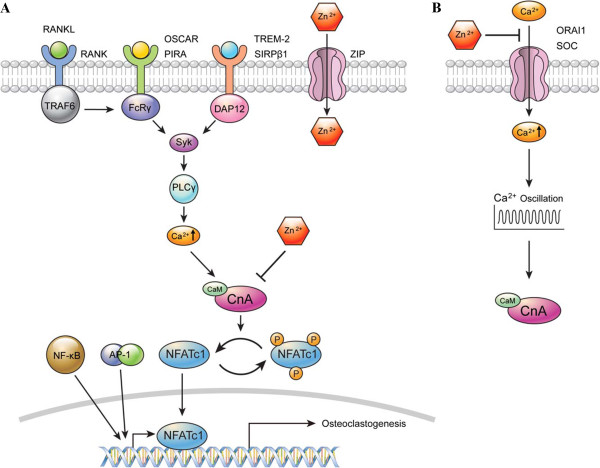
The proposed molecular mechanism for the inhibitory effects of zinc on RANKL-induced osteoclastogenesis. Schematic models of the inhibitory effects of zinc on the Ca2+-Calcineurin-NFATc1 signaling pathway; (A) Zinc may inhibit calcineurin in the cytosol in the early period of osteoclastogenesis. (B) In the middle or late period, zinc could be suppressing calcium oscillations by blocking calcium influx from extracellular space. Cn A, Calcineurin A subunit; CaM, Calmodulin; P, phosphorylated.